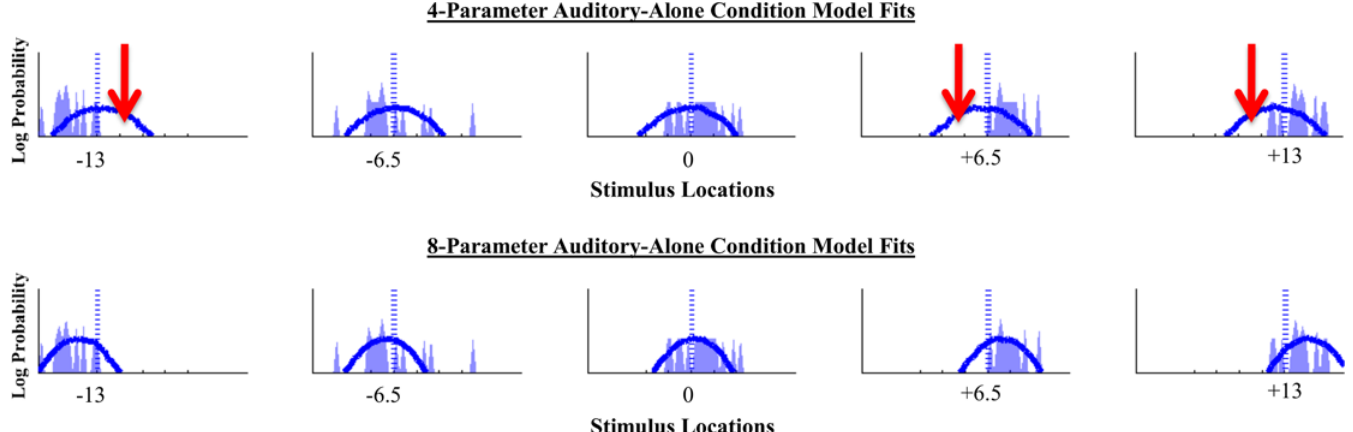
Fig 7. Auditory-alone condition model fits for one randomly selected subject. Plotted across the columns are model fits for each of the five auditory locations, from -13 to +13. The dotted light blue line shows the true stimulus location, the subject ’ s data is plotted in the shaded light blue regions, and the solid dark blue line shows the model ’ s fit to the data. As shown by the red arrows, simple models that assume unbiased sensory representations make considerable errors in estimating subjects ’ response, as simulated response distributions are centered near the true stimulus locations. By allowing the sensory representations to vary, biases can be more fully accounted for, as is shown in the fits for the 8-parameter model in the second row.